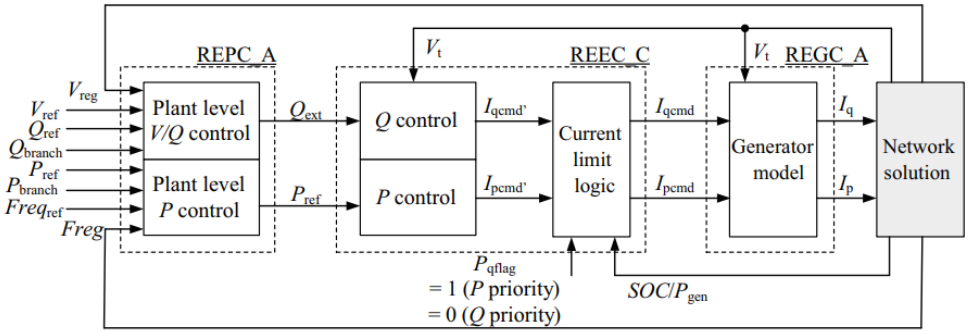
Figure 1. Graph of the relations of universal modules of the WECC energy storage system. Reprinted from Ref. [4] (Fig. 9), 2016, Xiaokang Xu.